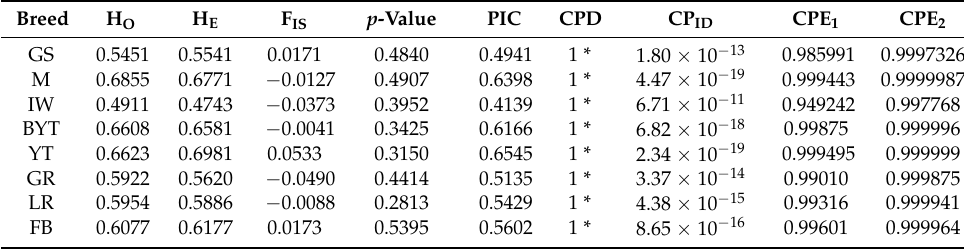
Table 4. Mean values of genetic parameters assessed for 21 STR loci of the study